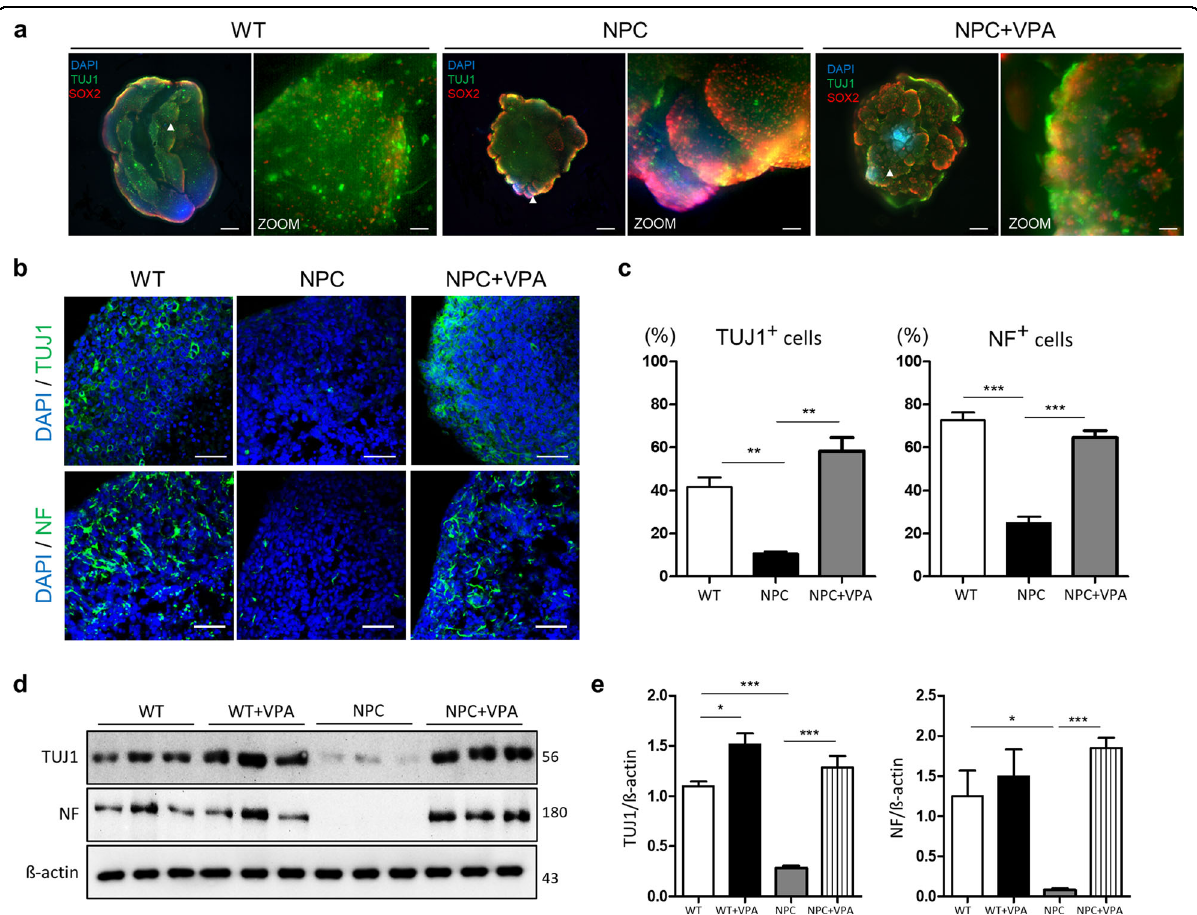
Fig. 6 VPA rescues neuronal differentiation in NPC organoids. a Clearing and immunostaining for TUJ1 and SOX2 in the NPC organoids after treatment with 1 mM VPA for 1 week. Scale bars, 500 μ m. Zoom scale bars, 60 μ m. b Immunostaining for neuronal markers (TUJ1 and NF) in the sections from the NPC organoids and VPA-treated organoids on day 28. Scale bars, 50 μ m. Zoom scale bars, 10 μ m. c Quanti fi cation of the expression of each marker was performed following the same method used in Fig. 2d. d , e Western blot analysis and quanti fi cation of TUJ1 and NF. n = 3 per group. The results are the mean ± SD. * p < 0.05, ** p < 0.01, and *** p <